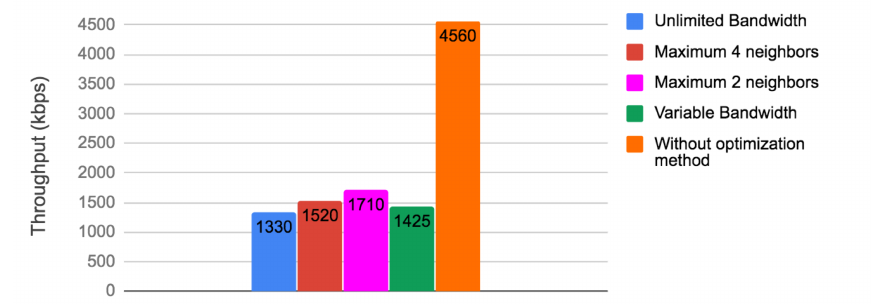
Figure 13. Total throughput comparison node among different available bandwidth using our proposed communication-reduced method vs. communication pattern without communication-reduced method. Note that in the whole system level our method met bandwidth constraints.